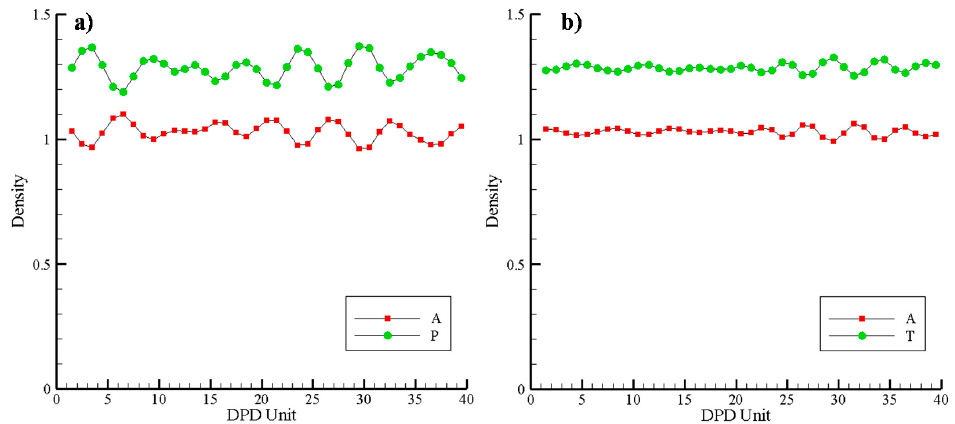
Figure 6. Comparison of densities of beads for ( a ) Nafion/PVPA blend membranes, ( b ) Nafion/PVTri blend membranes.